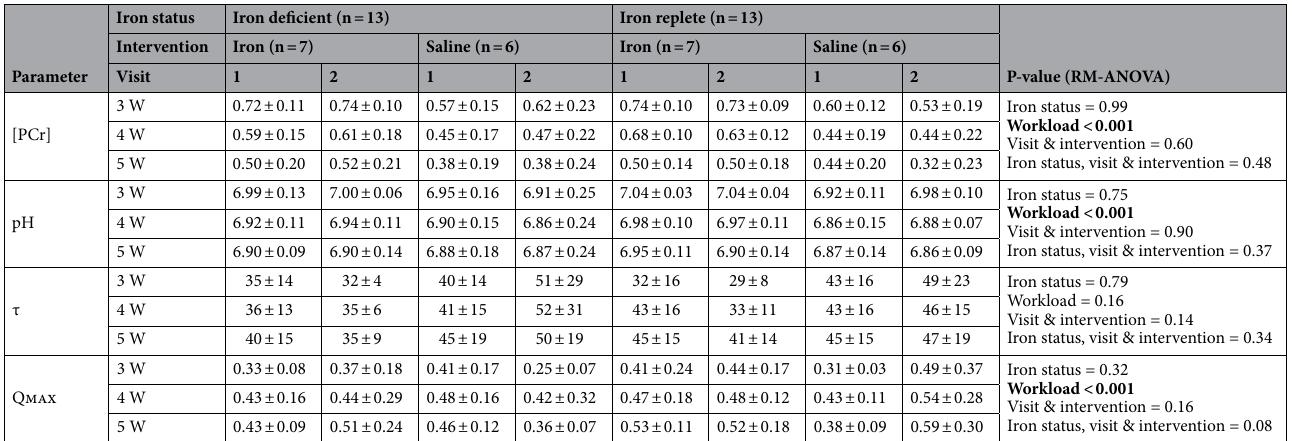
Iron status = 0.79 Workload =